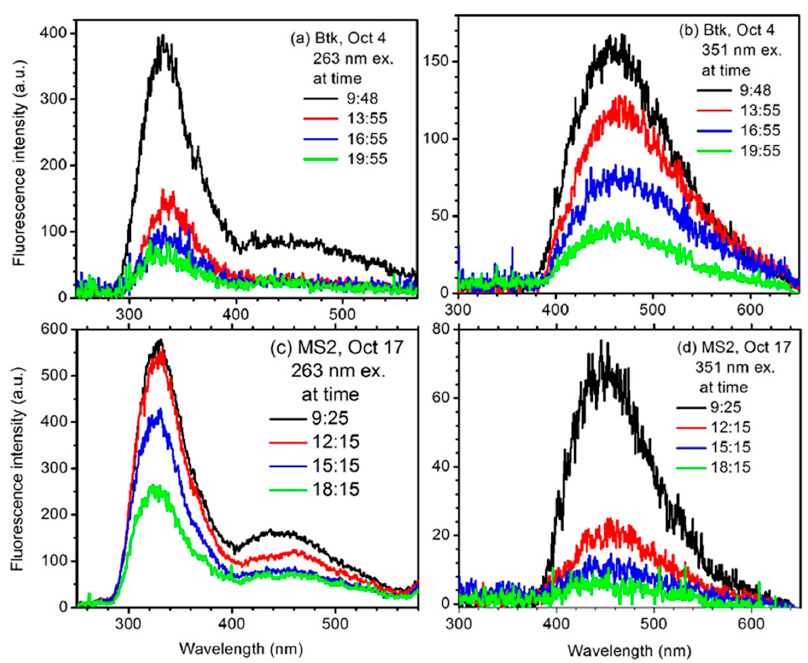
Figure 3. Representative wavelength resolved fluorescence spectra vs. time for Btk on 4 October 2012 ( a , b ) and MS2 on 17 October ( c , d ) at two excitation wavelengths: 263 nm ( a , c ) and 351 nm ( b , d ).